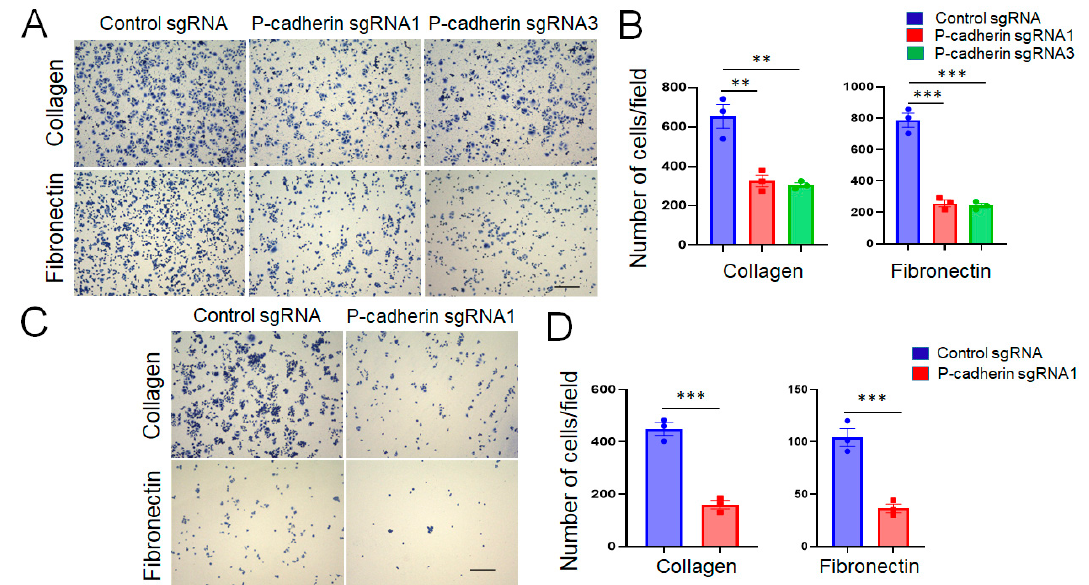
Figure 5. Loss of P-cadherin expression decreases intestinal epithelial cell adhesion to extracellular matrix. Control and P-cadherin-depleted HCA-7 ( A , B ) and SK-CO15 ( C , D ) cells, were plated on either collagen I, or fibronectin-coated plates and adherent cells were counted 1 h after plating. Representative images ( A , C ) and quantification of adhered cells ( B , D ) are shown. Means ± SE ( n = 4); ** p < 0.01, *** p < 0.005. Scale bars, 100 μ m. The results shown are representative of three independent experiments.